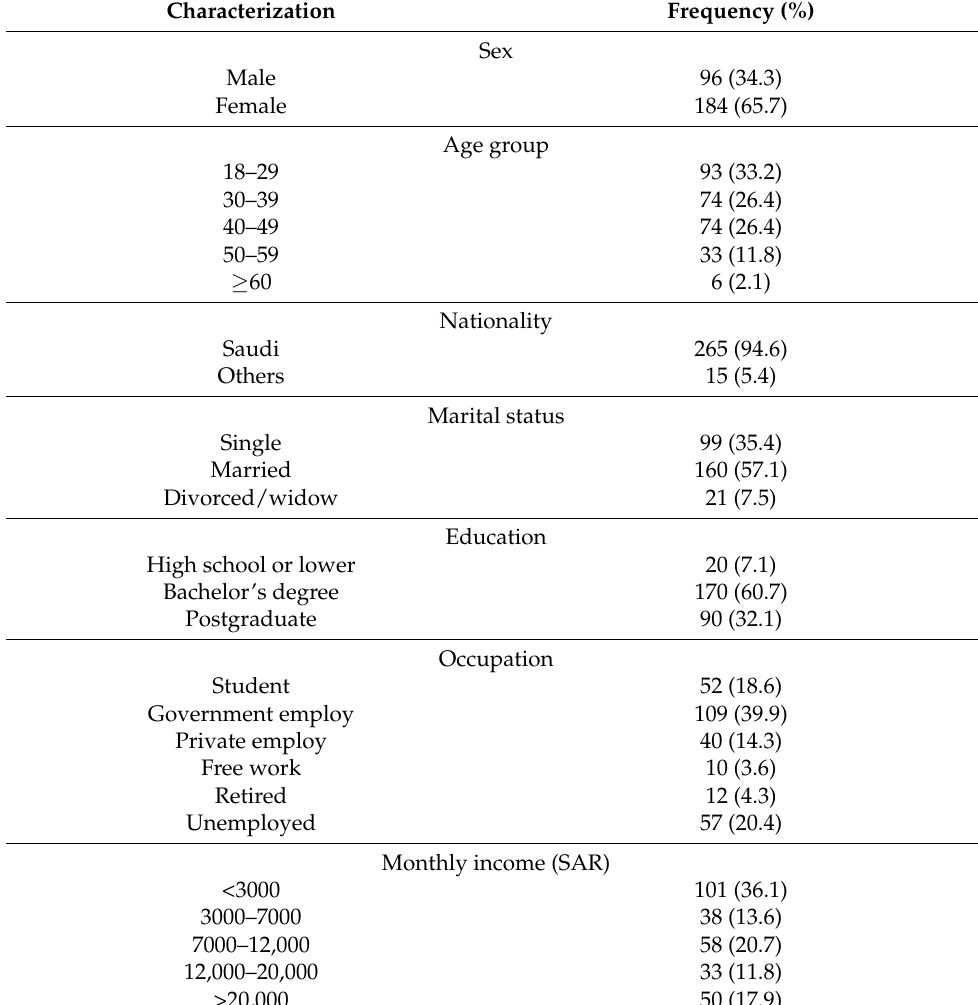
Table 1. Participants’ sociodemographic